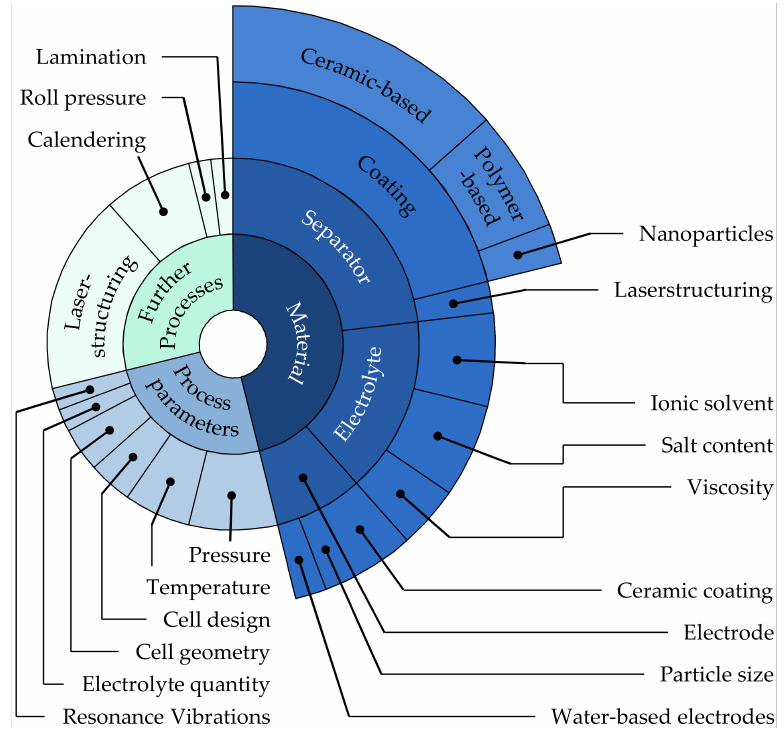
Figure 7. Representation of the labels and sub labels used in relation to their frequency of